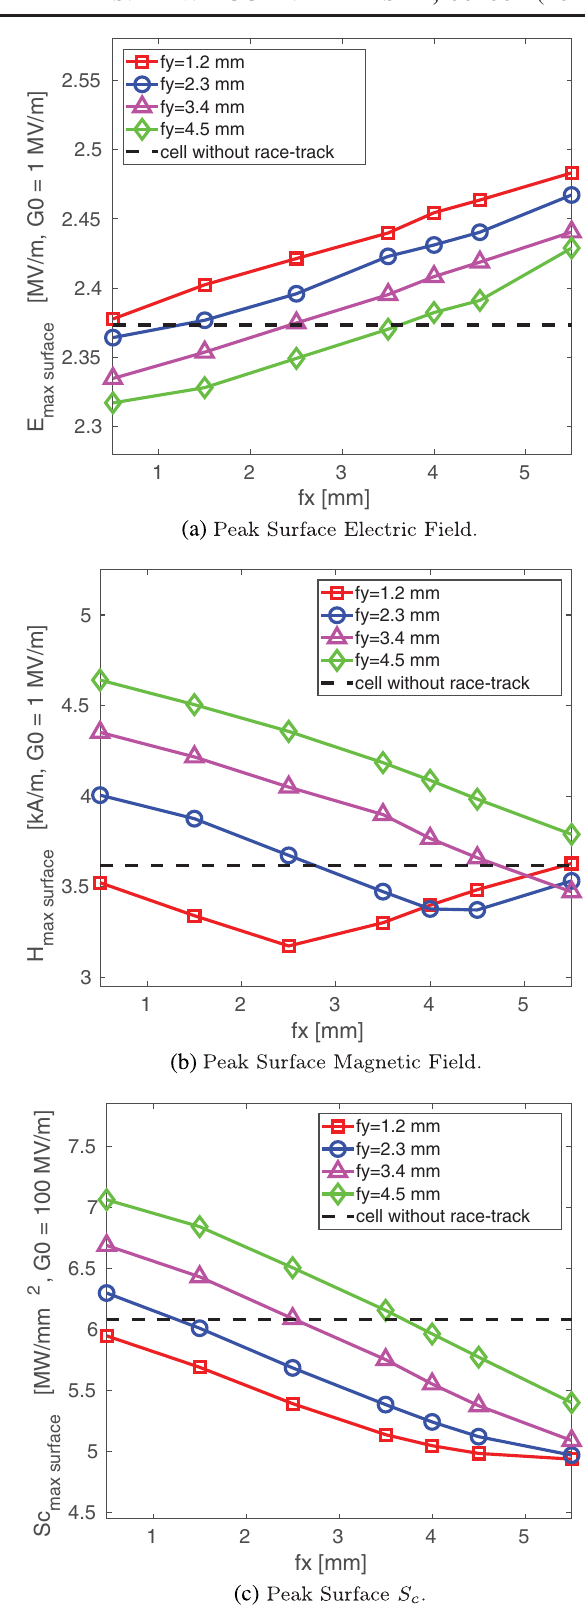
FIG. 6. Optimization of the straight sections, F x and F y , in the racetrack geometry.